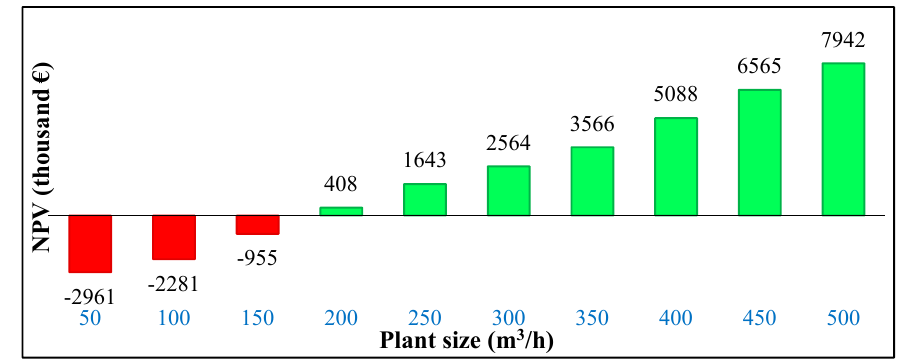
Figure 3. Profitability analysis of biomethane plants (thousand € )—baseline scenario. NPV—net present value.